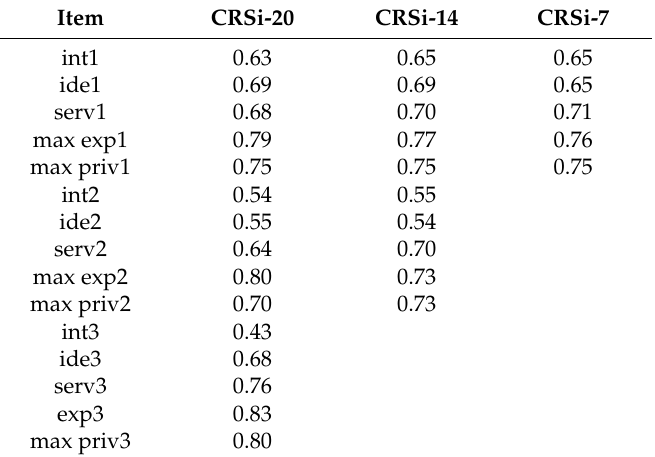
Table 3. EFA extracted loadings for interreligious CRS subscale